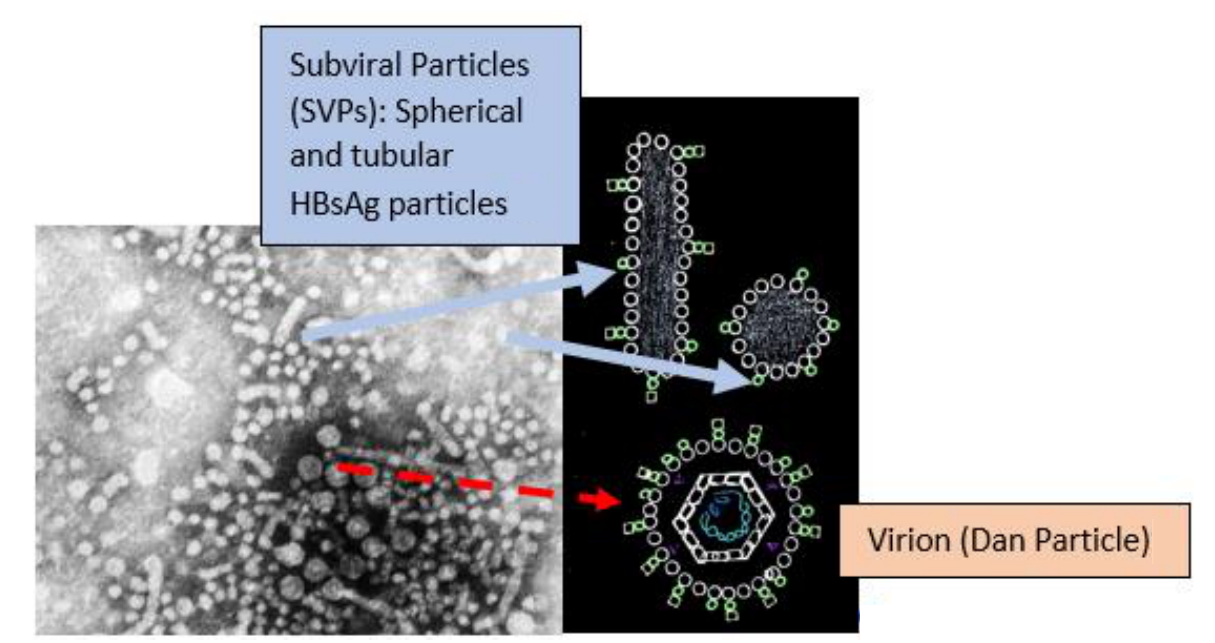
Figure 1. Electron microscope image has been taken from CDC’s public domain, and it is free of copyrights. The SVPs are non-infectious particles that contain only surface antigens (HBsAg) [8] which play a role in diverging the host immune response away from the virions [9]. SVPs are by far the most abundant source of HBsAg (>99.99% in the circulation) and are produced independently from viral replication and independently from cccDNA activity via integrated HBV DNA. HBsAg has important immunoinhibitory properties and its clearance during therapy is essential for achieving a functional cure [10]. Dane particles contain HBeAg, capsid (HBcAg), relaxed circular double-stranded DNA (rcDNA), DNA polymerase and reverse transcriptase [11]. The quantitative HBsAg test cannot distinguish HBsAg from the SVPs and virions in the serum [12]. To initiate the HBV life cycle (Figure 2), the newly formed HBV enters the bloodstream and attaches to the heparan sulfate proteoglycans (HSPGs) present on the cell surface membranes and gains entry into the hepatocyte via the sodium-taurocholate co-transporting polypeptide (NTCP) receptor [13] which is also used for the transportation of conjugated bile acids. The Large(L) HBsAg on the viral envelope forms an irreversible bond with the NTCP receptor and its co-receptor epidermal growth factor receptor (EGFR) [14]. The whole complex is then internalized into the cell via clathrin-mediated endocytosis or caveolin- dependent endocytosis